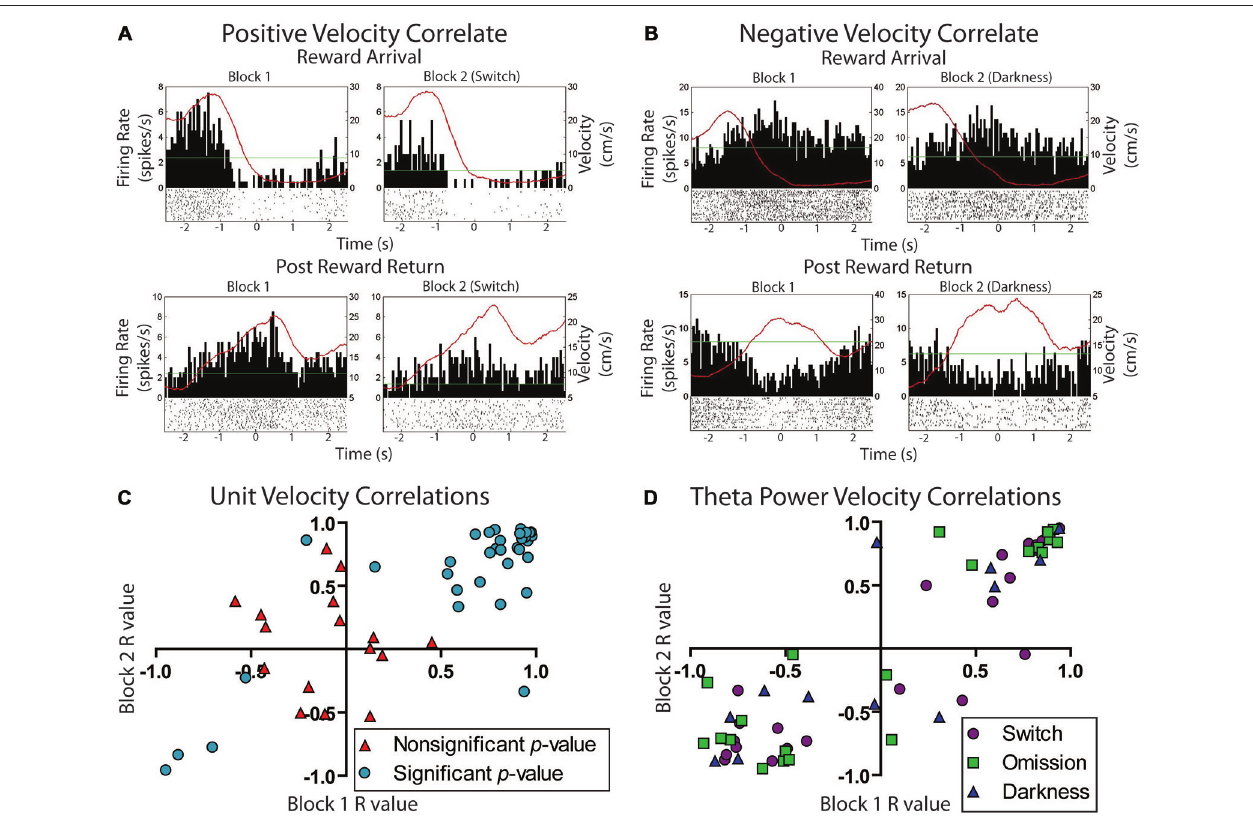
FIGURE 6 | Movement related activity in the lateral habenula. (A) Example unit positively correlated with velocity at both reward arrival and return to the center platform. (B) Example unit negatively correlated with velocity under the same conditions. The green line is the session average firing rate for each neuron. The red line is the average velocity of the rat across the peri-event time histogram. (C) Scatterplot showing the stability of individual neuron movement correlations prior to and after reward manipulation. Cells are divided into those that showed an overall significant correlation with velocity during the session and those that did not show a significant correlation for the session. (D) LFP correlation of Theta power with velocity across blocks. Channels are divided into the three possible reward manipulations that were experienced by